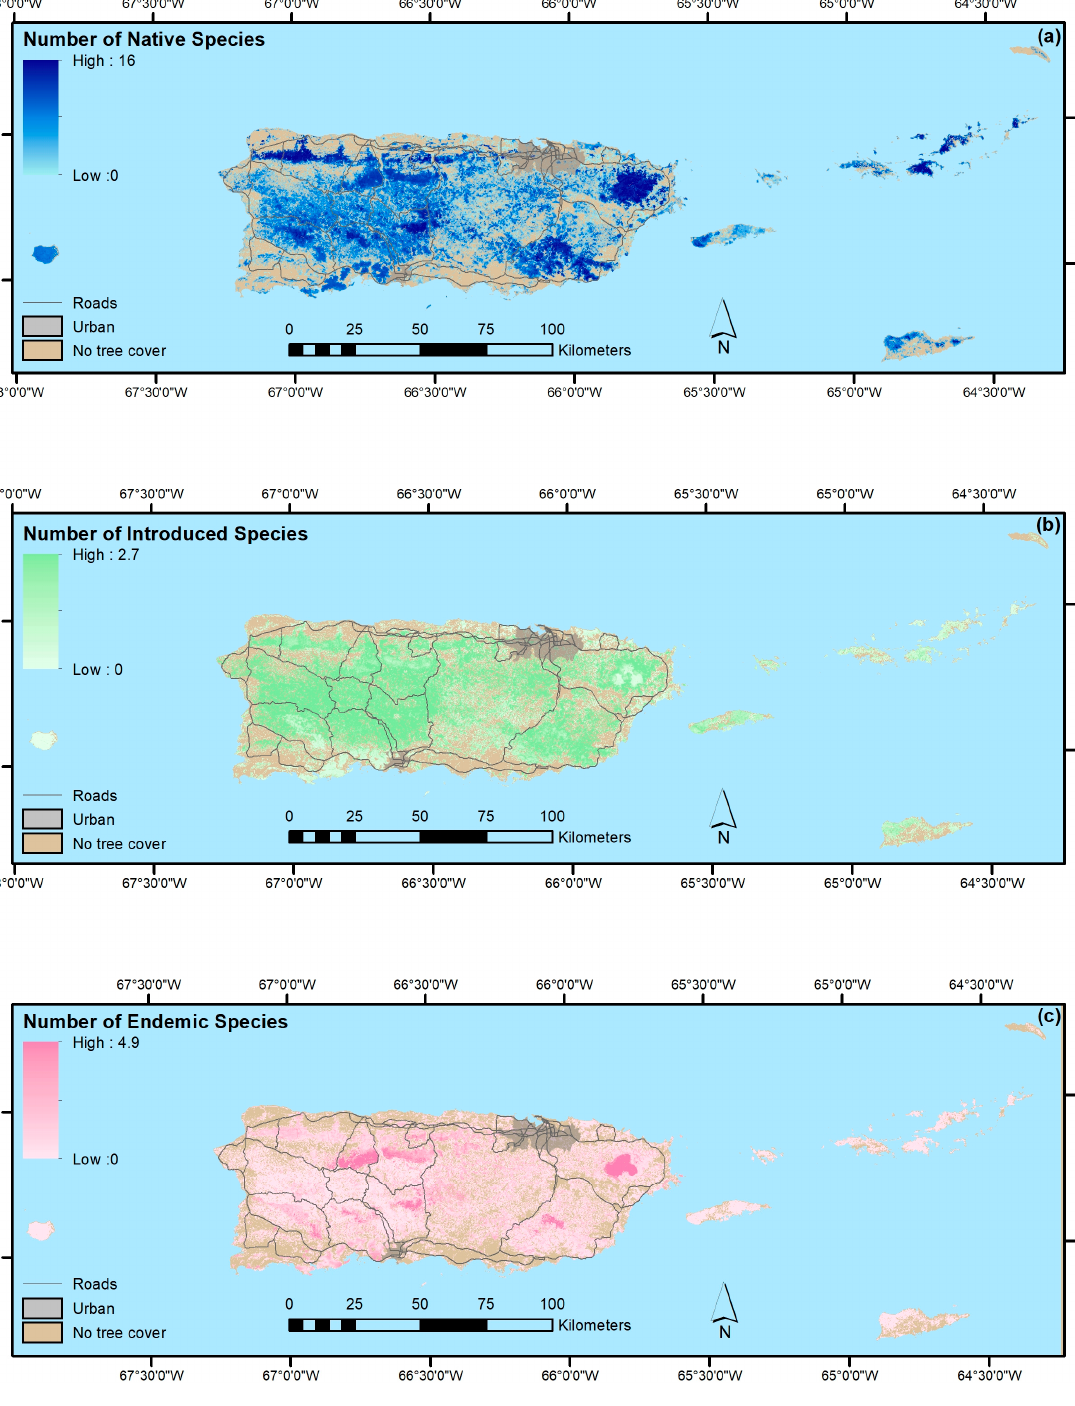
Figure 7. Plot-level counts of ( a ) native species, ( b ) introduced species, and ( c ) endemic species as mapped with Cubist regression tree models.